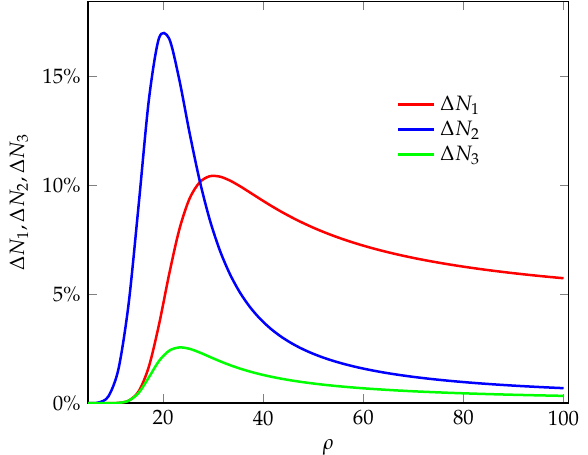
Figure 5. The percentage increase in the mean numbers of servicing requests vs. the offered load.